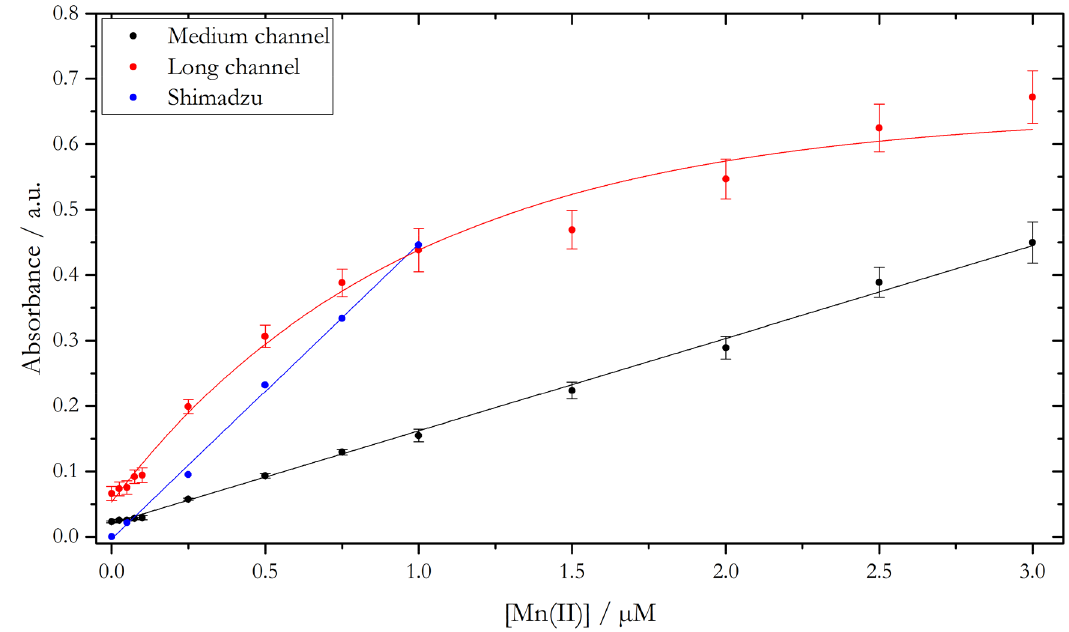
Figure 1. Calibration graphs for the detection of Mn using the PAN method (0.8 mM PAN in 4% v/v Triton-X100) acquired with the LoC analyser (long channel: 91.6 mm; medium channel: 34.6 mm; absorbance values were processed against a sample blank without the addition of PAN reagent) and a benchtop spectrophotometer (10 cm path length). Absorbance spectra from the spectrophotometer were measured against a reagent blank and processed at the absorption maximum of 562